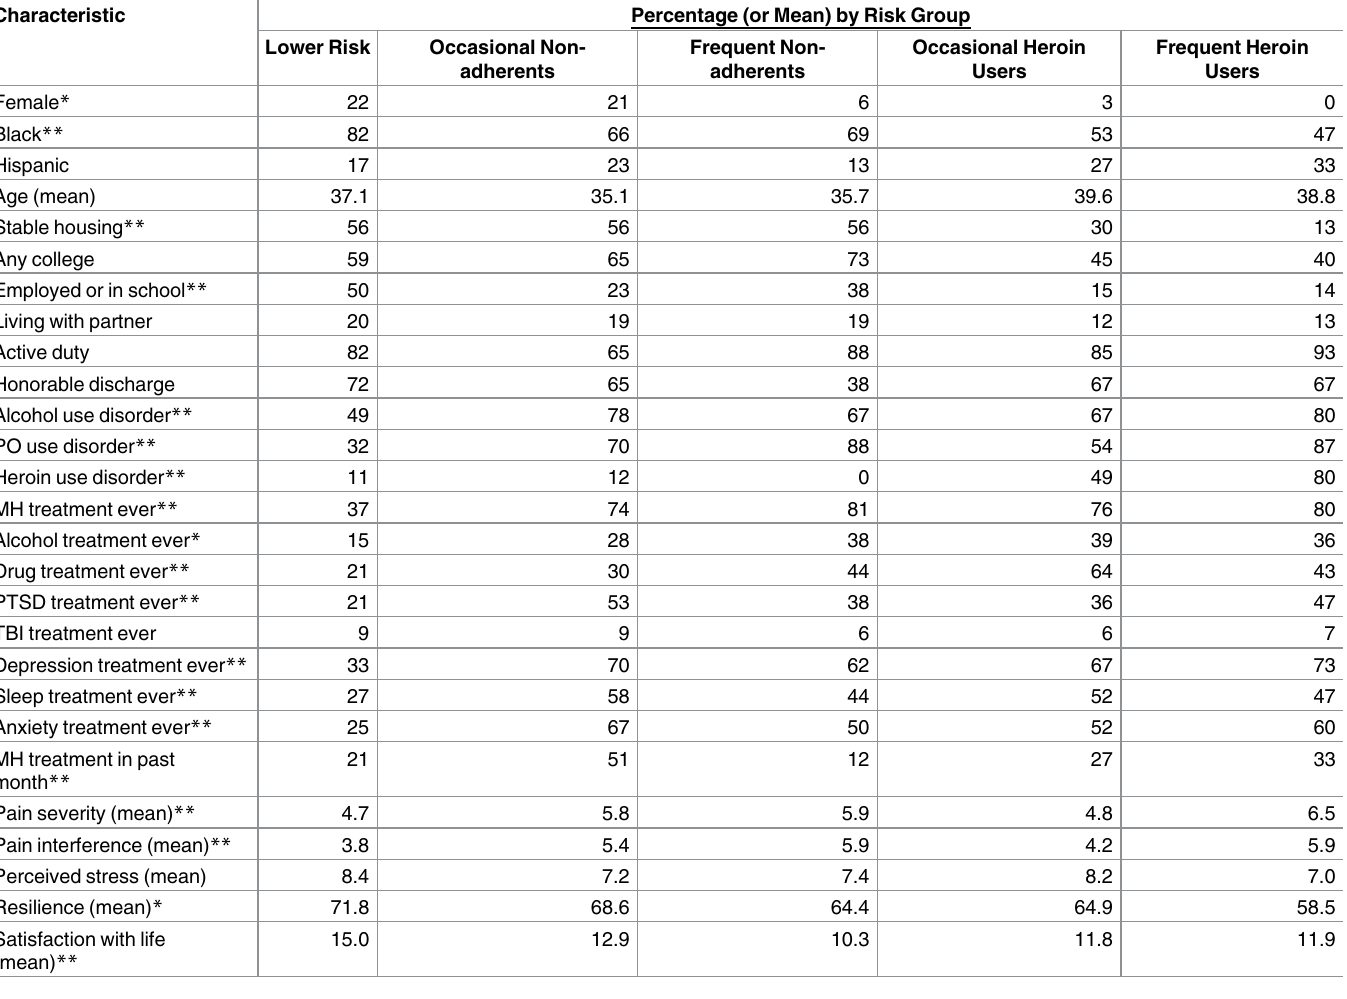
Table 5. Sample characteristics and variation across five opioid overdose risk